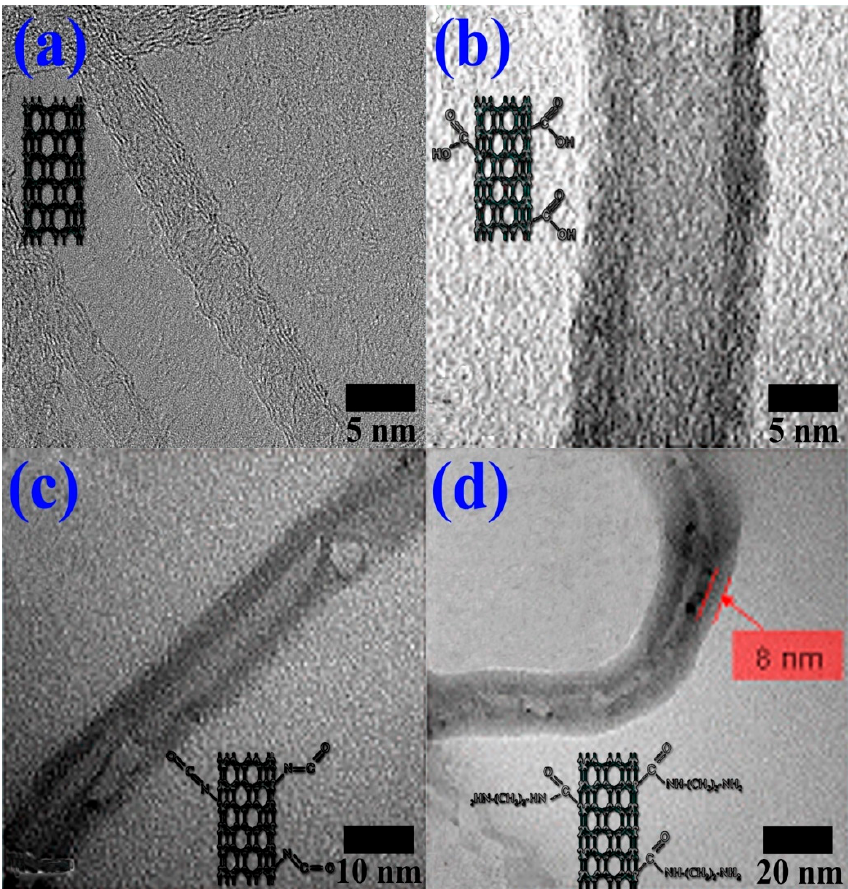
Figure 3. Transmission electron microscopy (TEM) images of ( a ) purified MWCNTs, ( b ) carboxylated MWCNTs, ( c ) isocyanated MWCNTs, and ( d ) polyamide 6 (PA6) grafted MWCNTs.